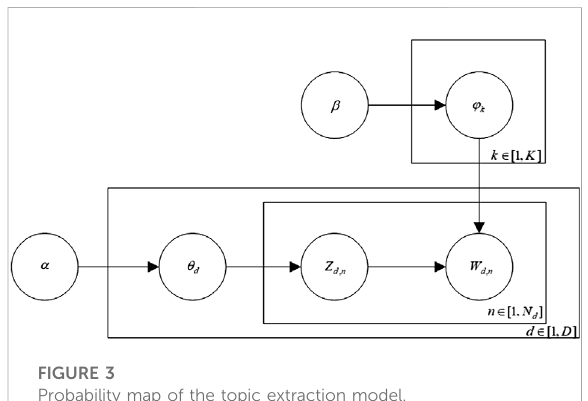
FIGURE 3 Probability map of the topic extraction